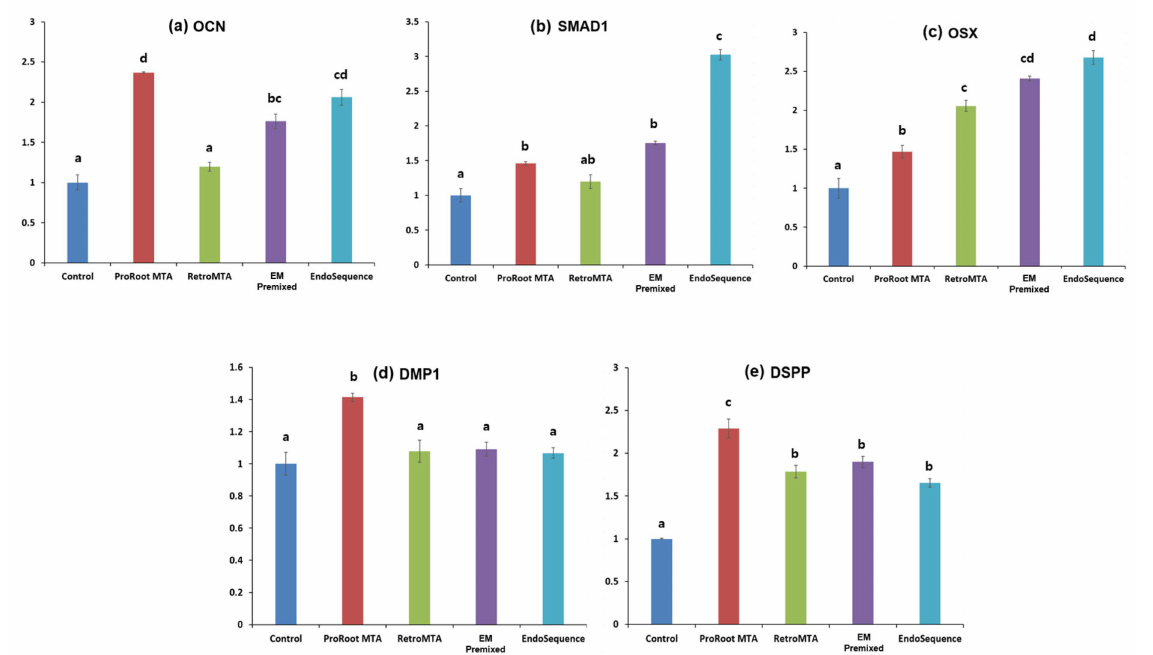
Figure 9. ( a – e ) mRNA expression of select genes. OCN, SMAD1 , and OSX on day 9. DMP-1 and DSPP on day 14. Different superscript letters mean statistically significant differences between experimental groups. Error bars mean standard